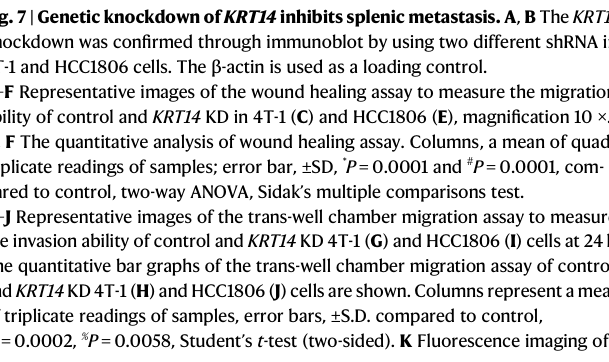
Fig.7|Geneticknockdownof KRT14 inhibitssplenicmetastasis.A , B The KRT14 knockdown was con fi rmed through immunoblot by using two different shRNA in 4T-1 and HCC1806 cells. The β -actin is used as a loading control. ability of control and KRT14 KD in 4T-1 ( C ) and HCC1806 ( E ), magni fi cation 10 ×. D , F The quantitative analysis of wound healing assay. Columns, a mean of quad- ruplicate readings of samples; error bar, ±SD, * P =0.0001 and # P =0.0001, com- pared to control, two-way ANOVA, Sidak ’ s multiple comparisons